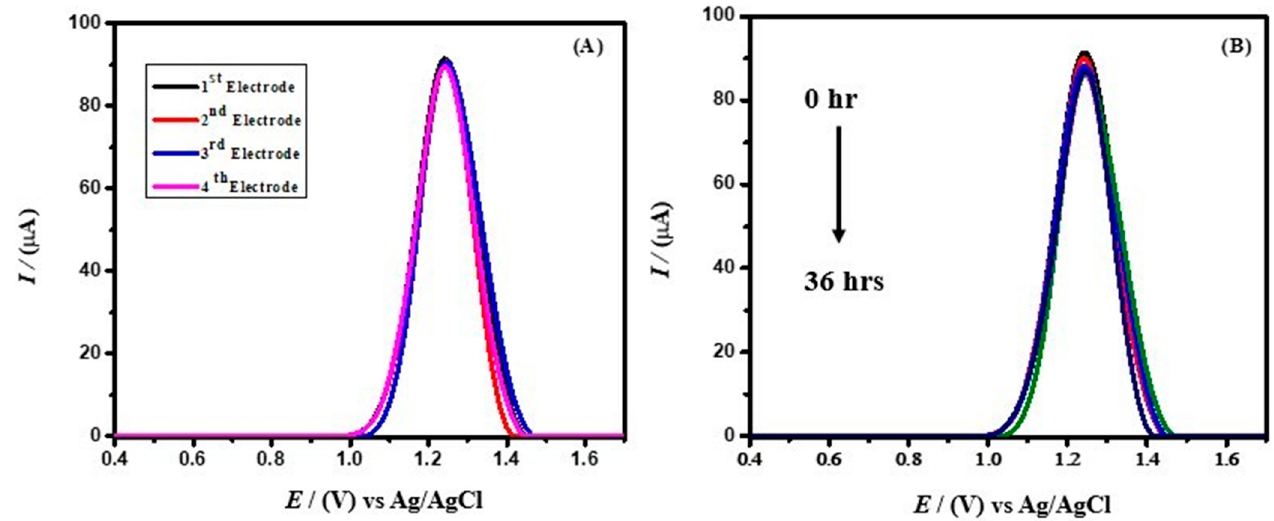
Figure 7. ( A ) DPVs of IBP showing reproducibility of the designed sensor using supporting